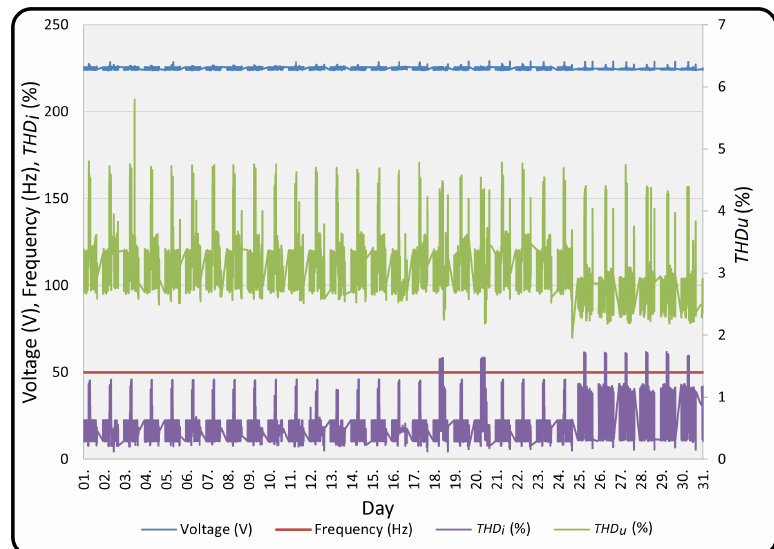
Figure 6. Variations in PQPs in August